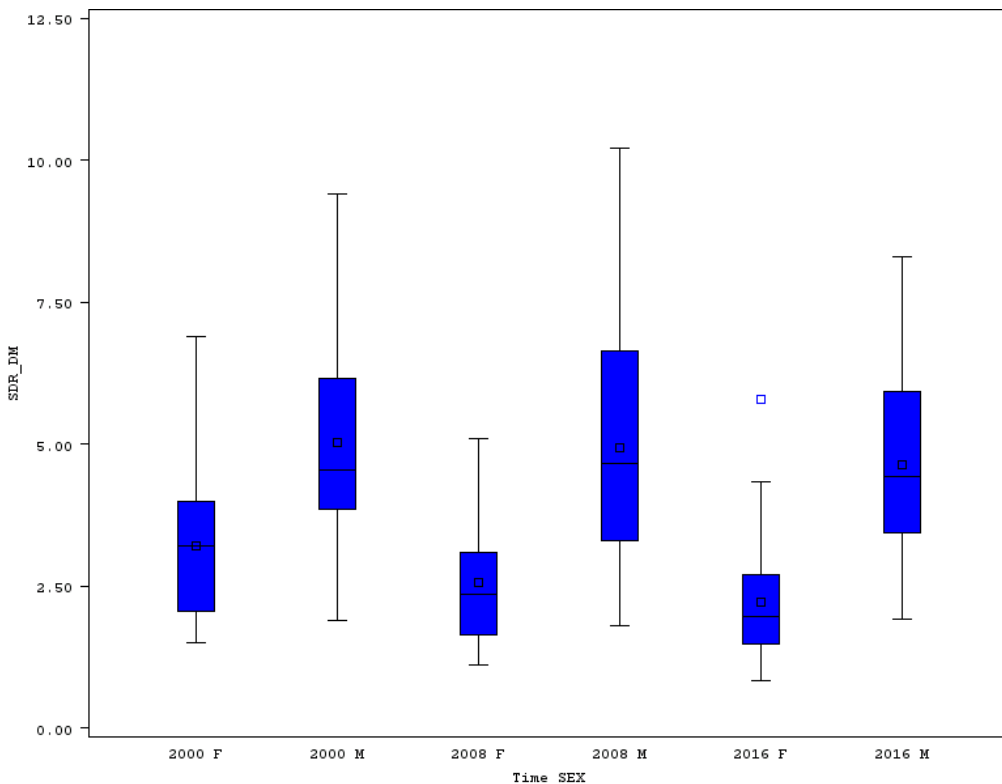
Figure 7. Boxplot of premature SDR for diabetes mellitus in EU countries for males and females in selected years. Source: Own calculations based on Eurostat database [20].